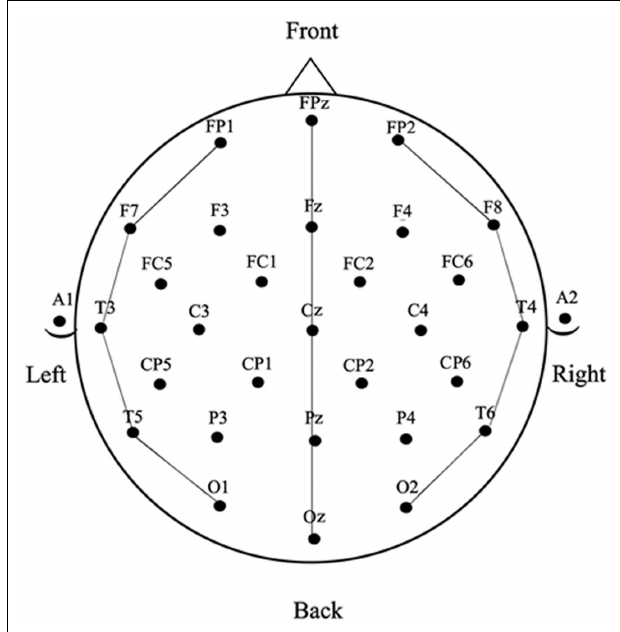
FIGURE 2 |Thirty-two-channel electrode